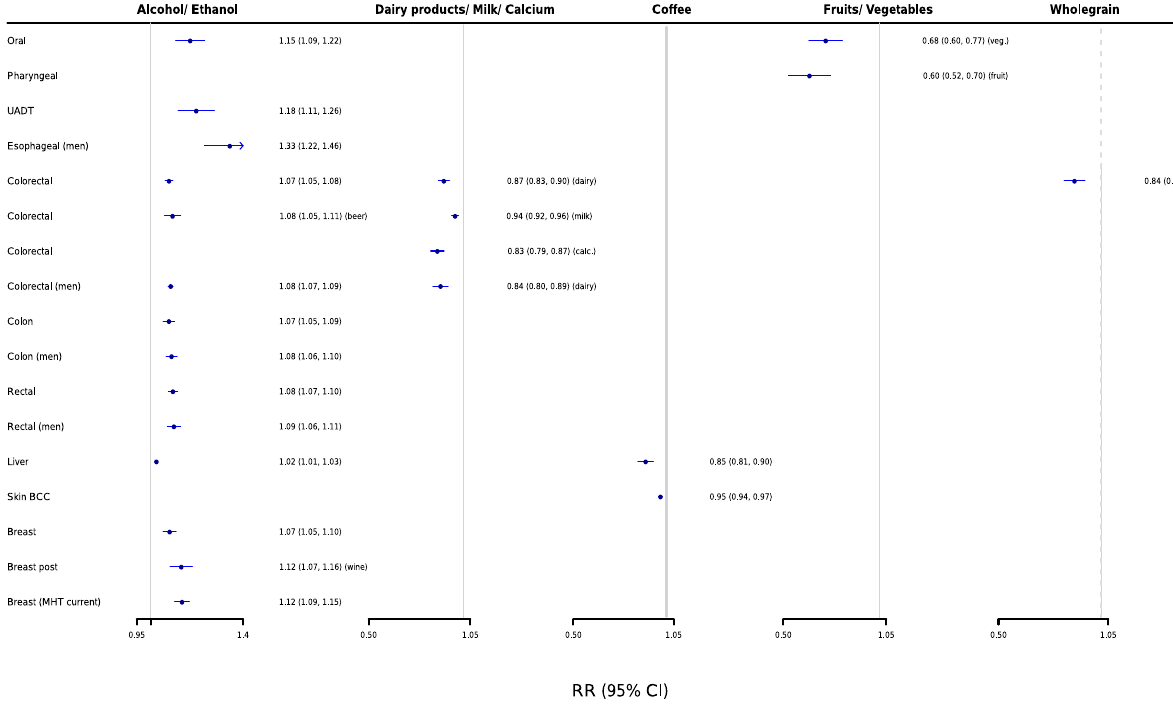
Fig. 2 Forest plot showing results that achieved strong or highly suggestive evidence from the umbrella review on diet and cancer risk. Data are presented as relative risks and 95% con fi dence intervals. BCC basal cell carcinoma, MHT menopausal hormone therapy, UADT upper aerodigestive